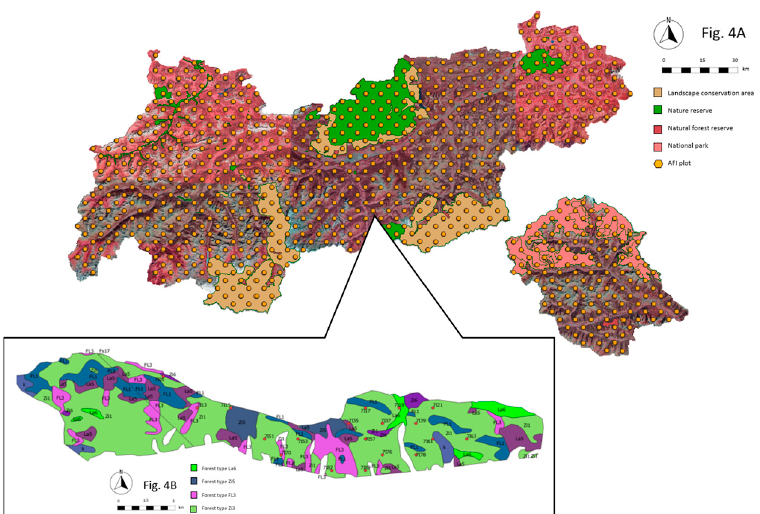
Figure 4. Dead wood reference levels in protected areas (47°15 ′ 13.468 ″ N, 11°36 ′ 5.353 ″ E). ( A ) AFI plots (orange dots) within protected areas (green, beige, and salmon-colored polygons) and protected area inventories are used as reference levels for dead wood quantity (cid:4666)𝐷𝑊 (cid:3044)(cid:3048)(cid:3028)(cid:3041)(cid:3047)(cid:3036)(cid:3047)(cid:3052) (cid:4667) . ( B ) In addition, nature forest reserves and protected area inventories are surveyed. Within a forest type, the respectively highest dead wood quantity out of all inventory data sets is compared to the actual subplot level.